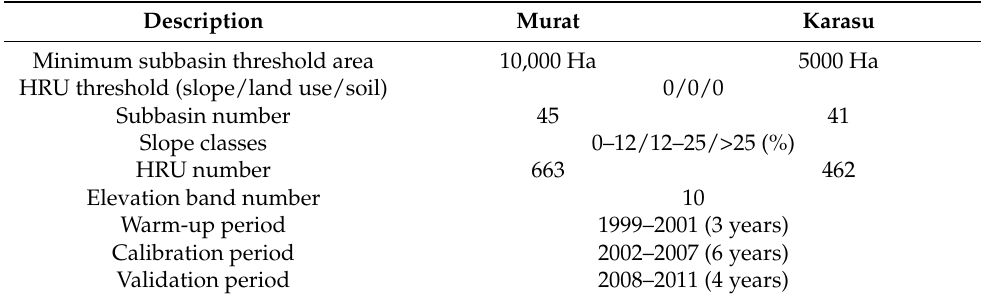
Table 2. Base model setup descriptions for each